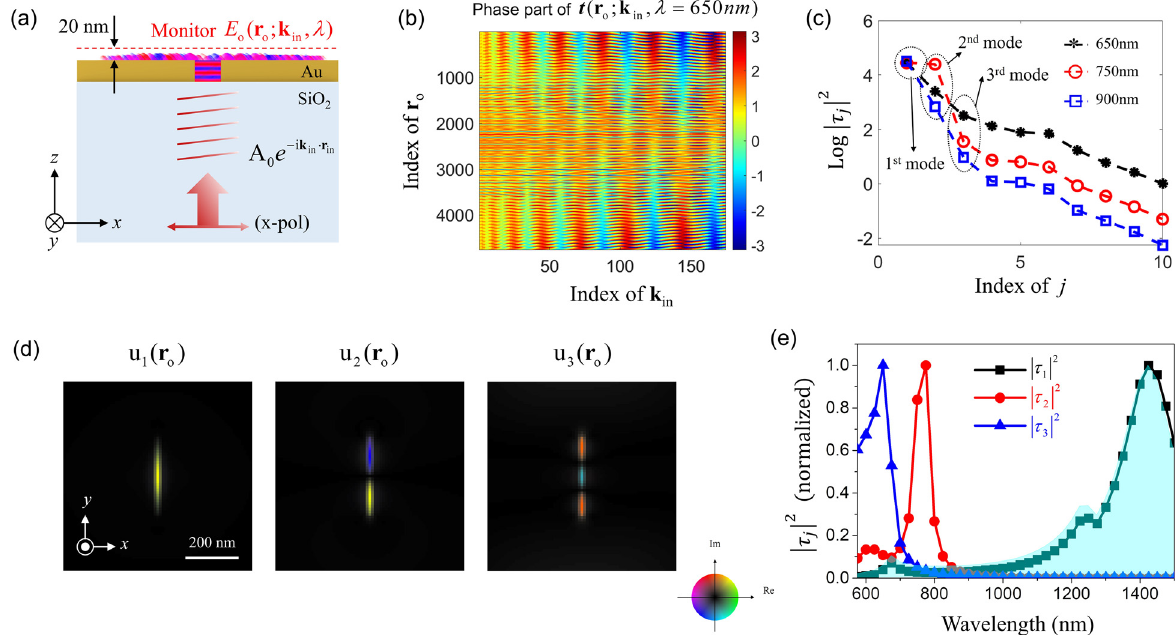
Figure 3: T-matrix-based mode analysis for single-slot nanoantenna. (a) Simulation schematic diagram of T-matrix-based mode analysis. (b) Phase part of T-matrix constructed from the near-field complex-field maps obtainedfrom the monitor in(a) at wavelength 650 nm. The columnindexindicates k in sortedin increasingorder of magnitude.The row index describes r o sorted in increasing order of its magnitude; only the phase part of the T-matrix is shown. (c) Squares of singular values, ⃒⃒⃒⃒ ⃒⃒⃒⃒ 2 , of T-matrices sorted in descending order. The fi rst three eigenvalues are related to the meaningful eigenmodes of the single-slot τ ( λ ) j nanoantenna,whoseindicesareindicatedbyblackdashedcircles.Black,red,andbluegraphsindicatetheenergydistributionsfromthe650, 750,and900nmwavelengths,respectively.(d)Complex- fi eldmapsofeigenmodesobtainedfromthe fi rstthreecolumnsoftheunitarymatrix U of the T-matrix in (b). Circular color map: real and imaginary values of the complex fi eld. (e) Normalized energy spectrum of each individual eigenmode. The light-blue window indicates normalized transmittance with normally incident beam from Figure